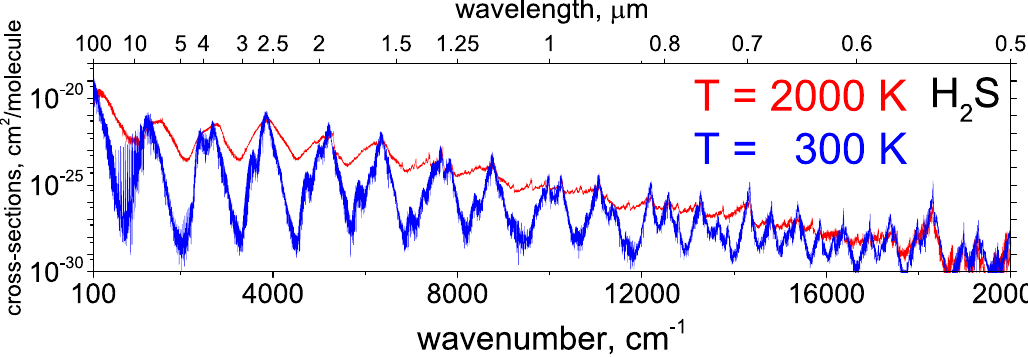
Figure 5. Cross sections for hydrogen sulfide generated using the ExoMol line list for H 2 S [65].